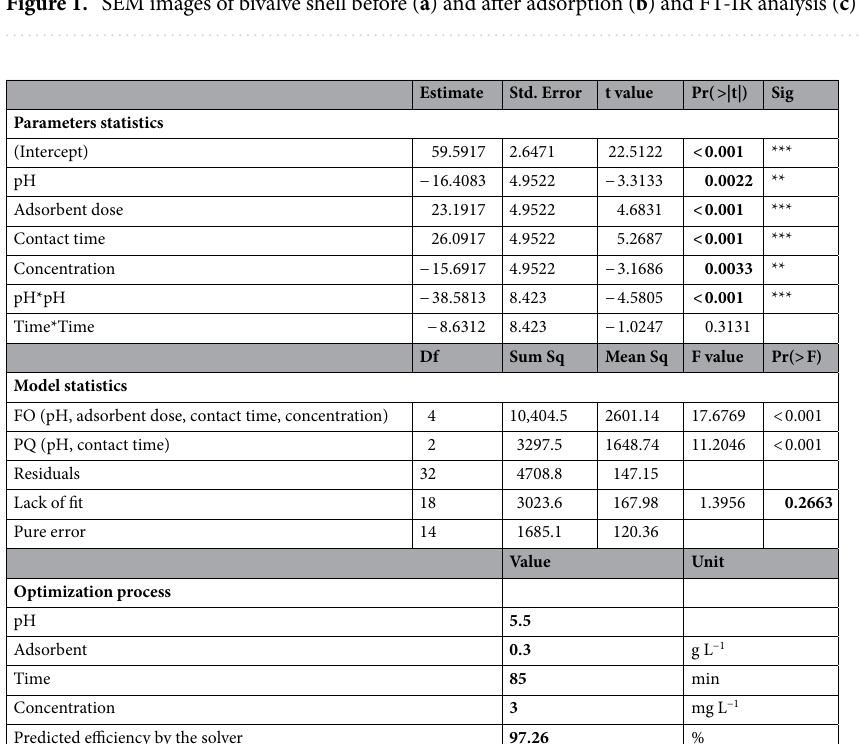
Table 2. ANOVA test for CCD modeling and results of process optimization. Significant values are in bold.